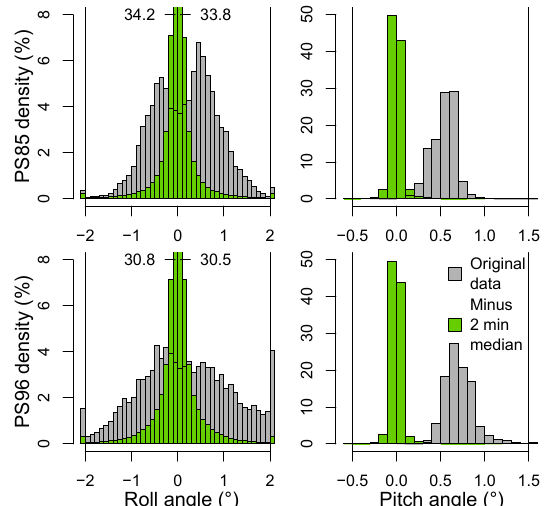
Figure 3. Frequency distribution of the ship angle (grey) and ship angle minus a 2min running median (green) during the measure- ment